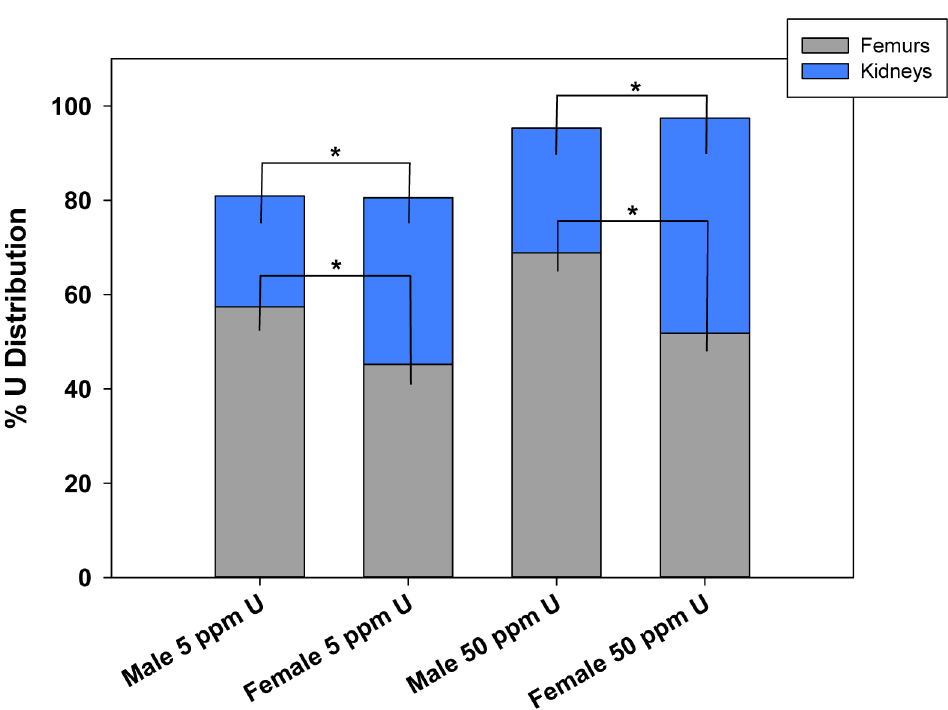
Fig 3. The percentage of total uranium distributed in femur bones and kidneys in male and female mice. The percentage of total uranium located in the femur bones and kidneys was calculated from ICP/MS data. Graph indicates mean percent uranium distribution +/- S.D. of the mean for each tissue in male and female mice. n = 6 or 7/ group. (cid:3) p < 0 . 05 ;Students t-test, comparing male and female mice at the 5 and 50 ppm uranium concentrations.